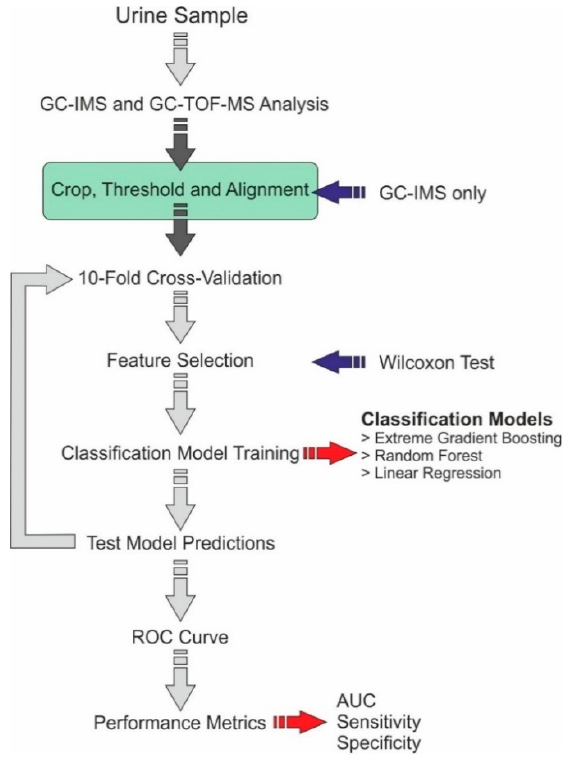
Figure 1. Data analysis pipeline.